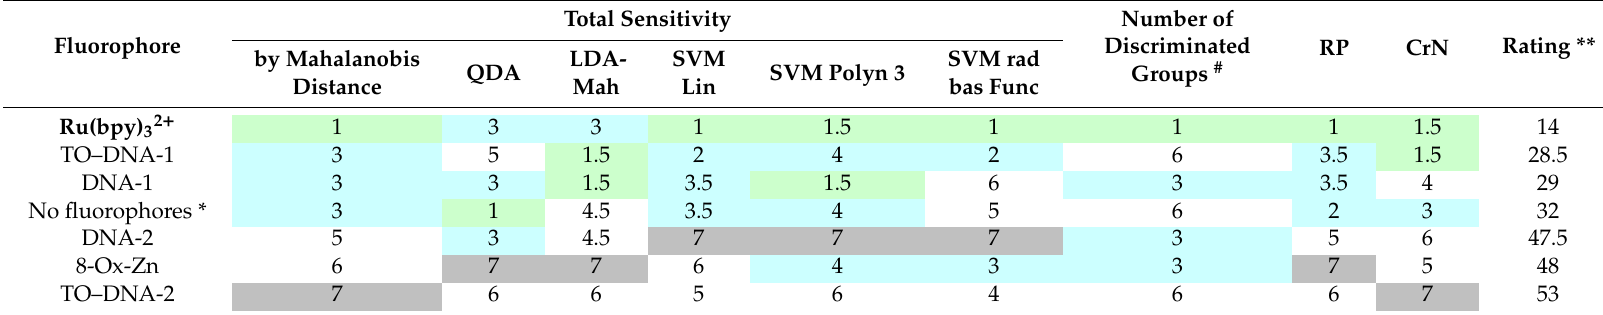
Table 2. Places of fluorophores by metric values (TS, CrN, RP etc.,) in the discrimination of 36 honey samples and their overall rating values of fluorophores calculated as the total sum of places by each